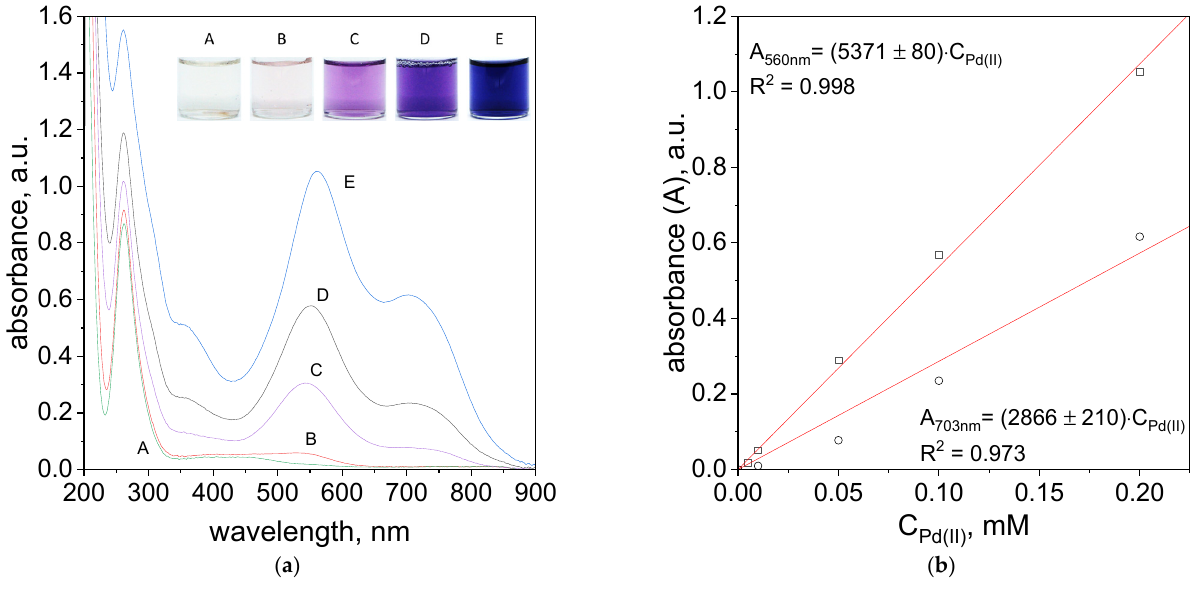
Figure 9. Spectra of solutions containing mixture of TR, Pd(II) and Pt(IV) ions, after 1 h ( a ); dependency of absorbance vs. initial Pd (II) ions, after 1 h, wavelength: 560 nm and 703 nm ( b ). Conditions: C 0TR/C0Pd(II): A: 5 × 10 − 6 mol/dm 3 , B: 5 × 10 − 5 mol/dm 3 , C: 1 × 10 − 5 mol/dm 3 , D: 1 × 10 − 4 mol/dm 3 , E: 2 × 10 − 4 mol/dm 3 , C 0Pt(IV) = 5 × 10 − 5 mol/dm 3 , volumetric ratio mixing Pd (II) ions and TR 2.5 mL:1.5 mL, pH = 4.10, T = 60 ◦